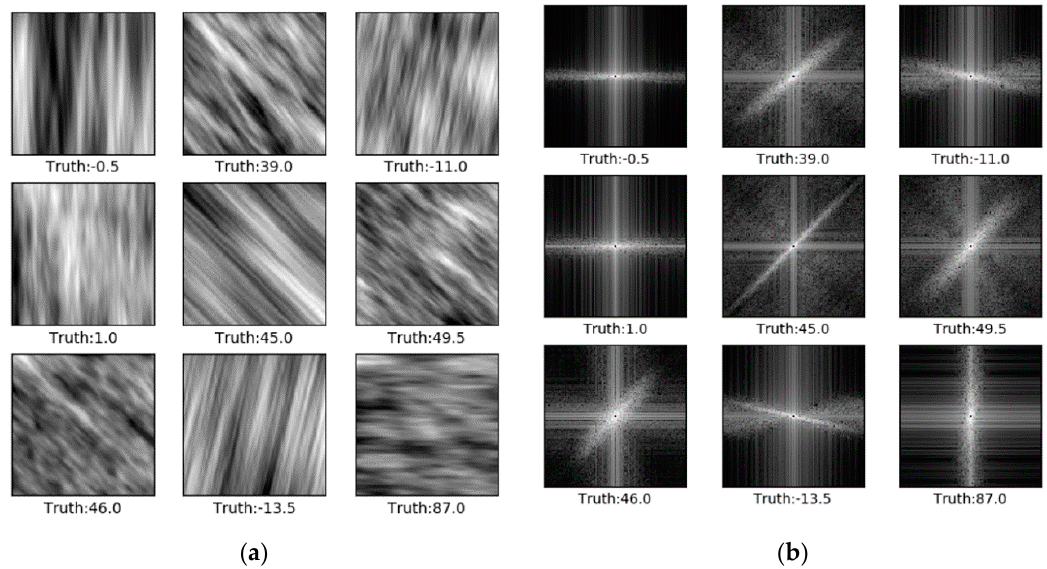
Figure 6. Artificial STI generated by Perlin noise. ”Truth” labels indicate designated angles (in degrees): ( a ) original images; ( b ) 2D Fourier transform images.